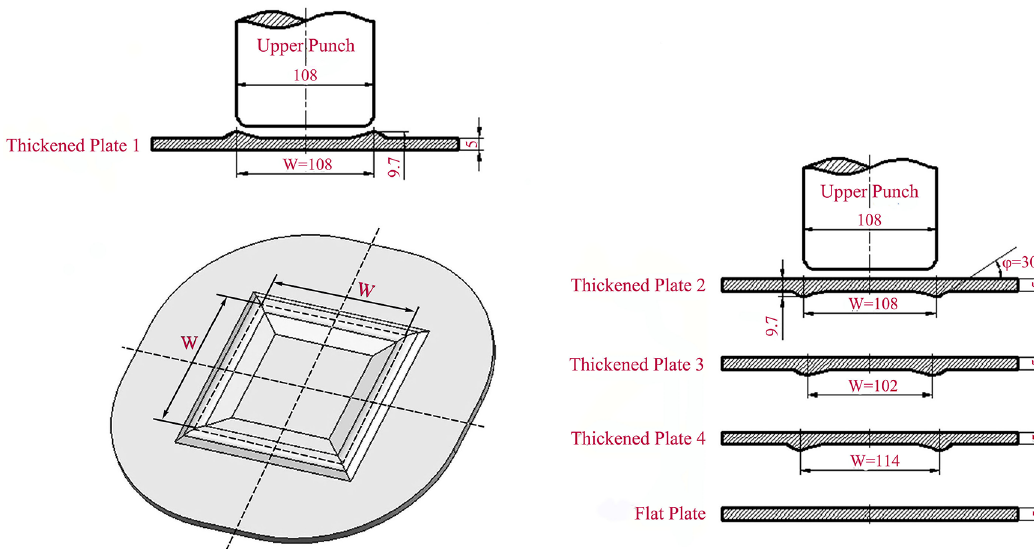
Fig. 1. Shape and size of the local-thickened plates and fl at plate used in square cup hot